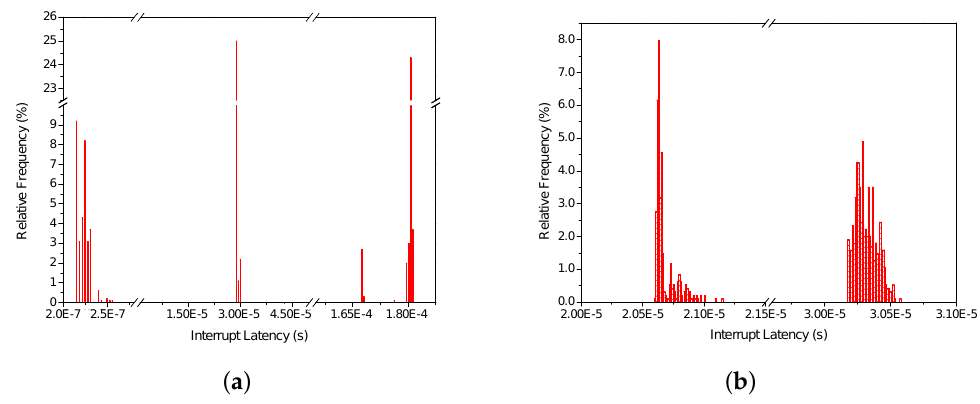
Figure 8. Relative frequency histogram of interrupt latencies (s). ( a ) guest interrupt latencies; ( b ) task interrupt latencies.